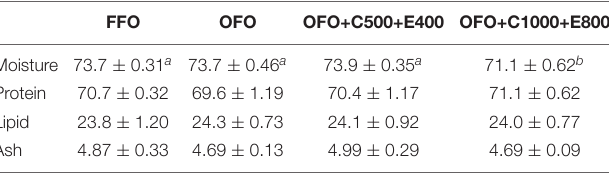
TABLE 3 | Muscle proximate composition of rainbow trout fed the experimental diets for 10 weeks (% dry weight basis). FFO